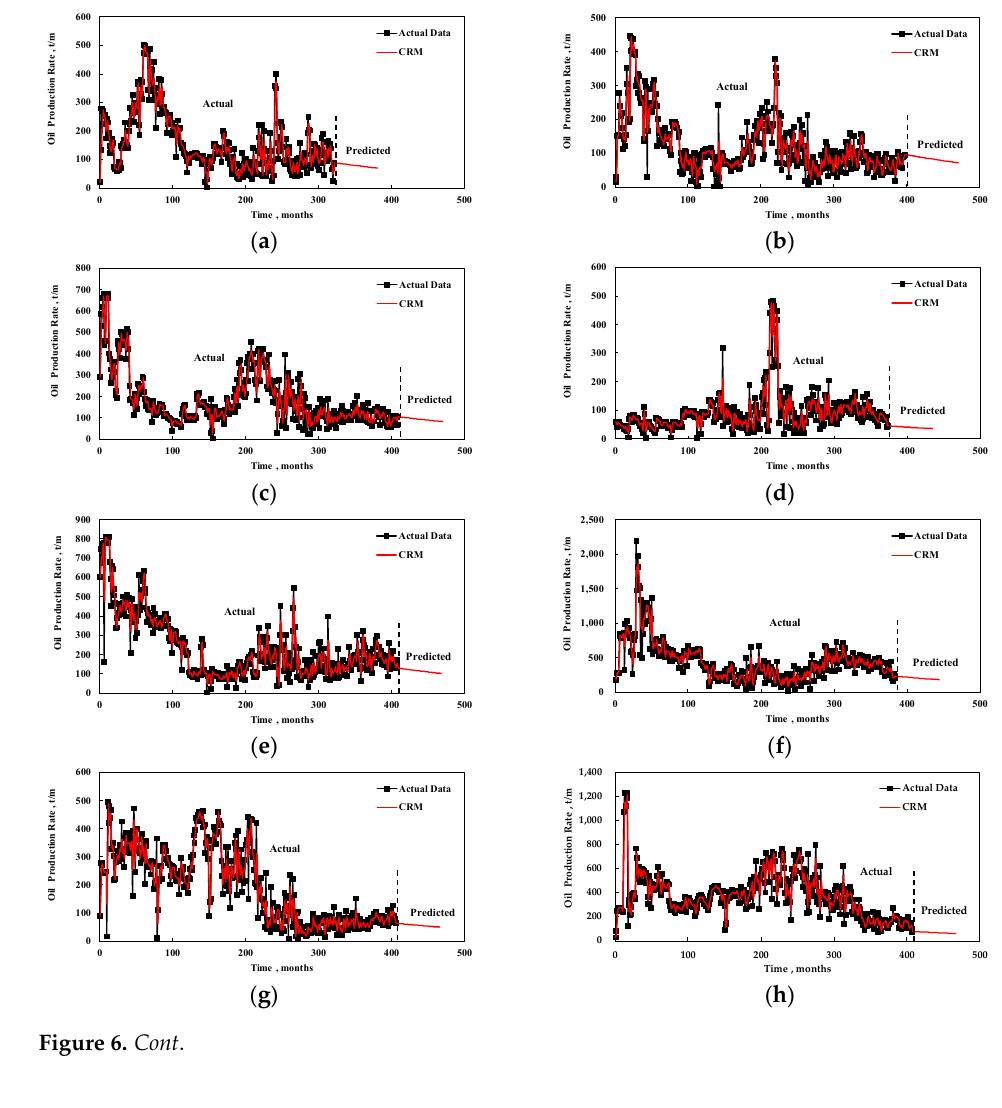
Figure 6. Comparison between the actual oil production data and the calculated oil production data by combining modified CRM and the waterflooding characteristic equation. ( a ) Producer 1499, ( b ) Producer 1500, ( c ) Producer 1501, ( d ) Producer 1511, ( e ) Producer 1512, ( f ) Producer 1519, ( g ) Producer 1520, ( h ) Producer 1521, ( i ) Monthly liquid production of the well group, ( j ) Accumu- lative liquid production of the well group. 4. Conclusions Herein, the method integrating a modified CRM with the waterflooding performance equation is introduced for production prediction: (1) The productivity equation derived from the injection–production balance system and the modified capacitance–resistance model established with consideration of the well-influenced boundary have been proven to better correspond to the observed production situation in the actual